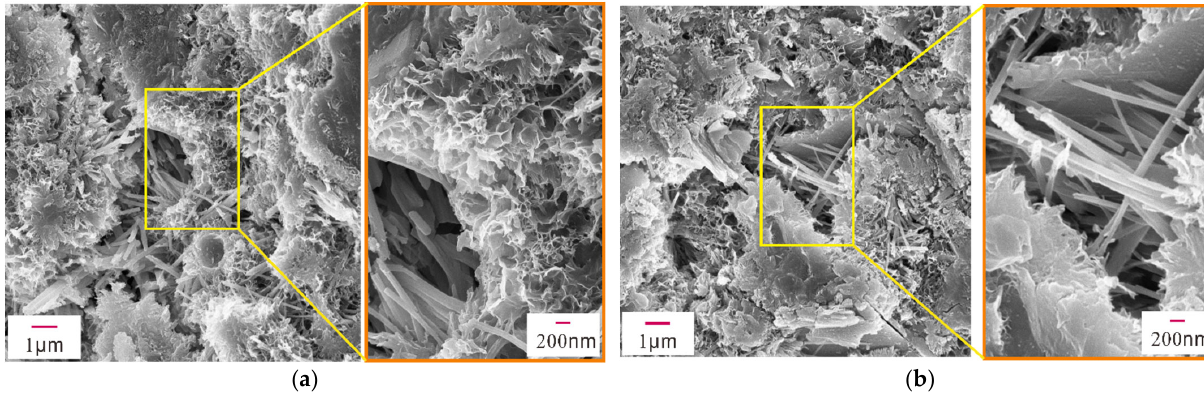
Figure 7. SEM images of sample 5N. ( a ) Partial SEM image of sample 5N, ( b ) Partial SEM image of sample 5N.